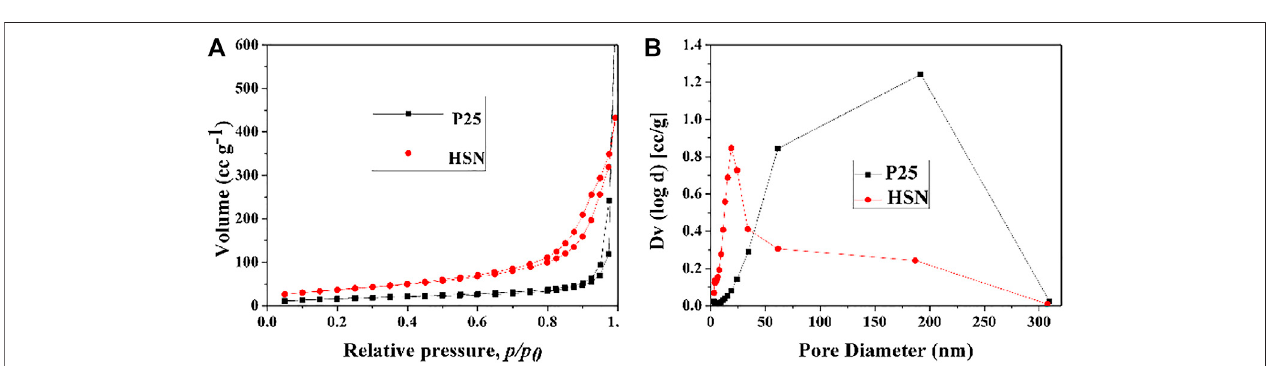
FIGURE 2 | N 2 adsorption isotherms (A) and pore size distribution curves (B) of TiO 2 HSN and P25.